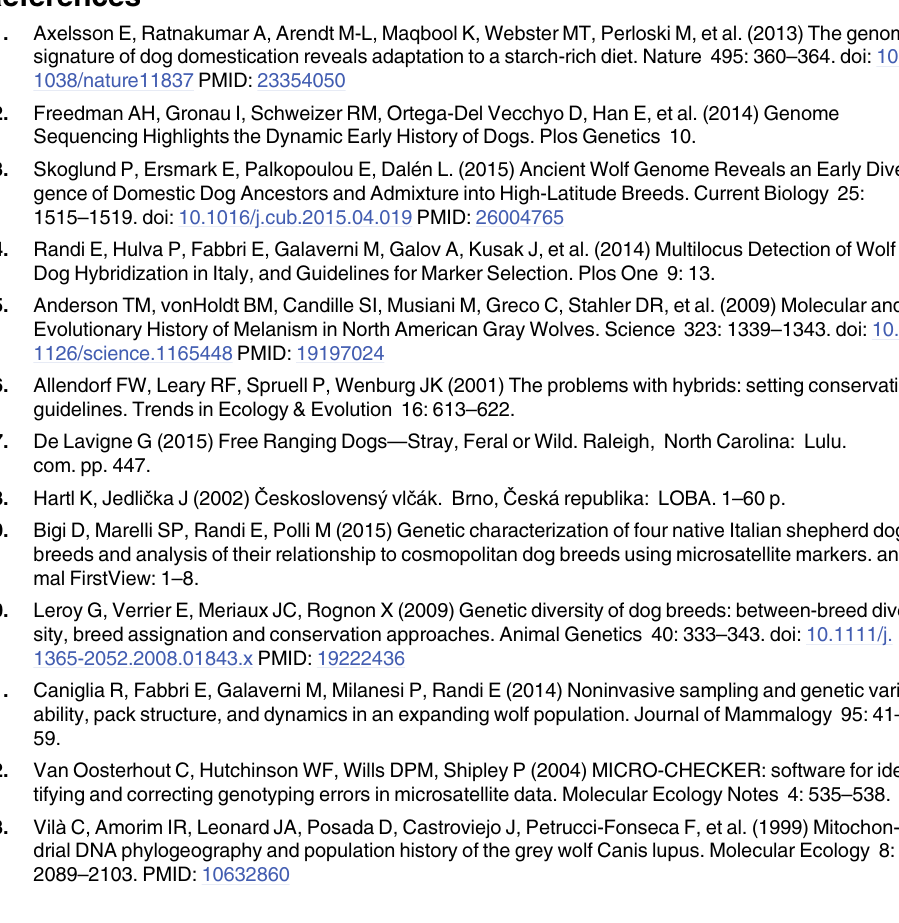
S1 Table. Parameters of analysis in STRUCTURE for K1-K5. S2 Table. Genotypes and population size (N) after 25 generations of mating simulated using program